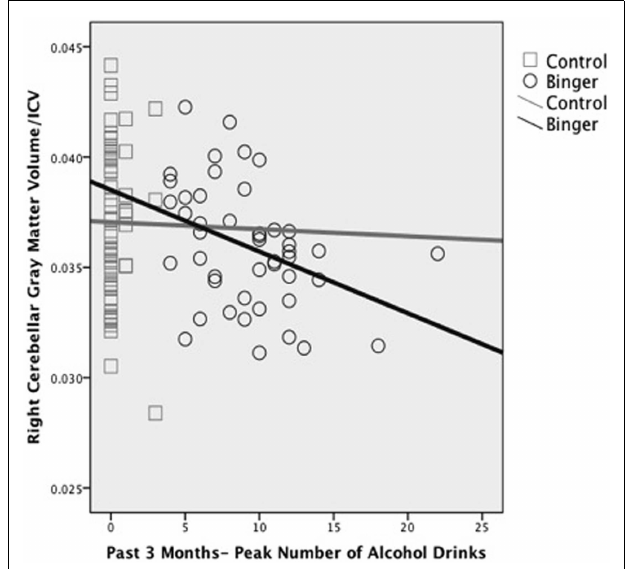
FIGURE 2 | Reduced right hemisphere cerebellar gray matter volume (corrected for intracranial volume) associated with peak number of alcohol drinks consumed in the past 3months in binge drinking ( n = 46) and control ( n = 60) adolescents (adapted from Lisdahl et al., 2013) .